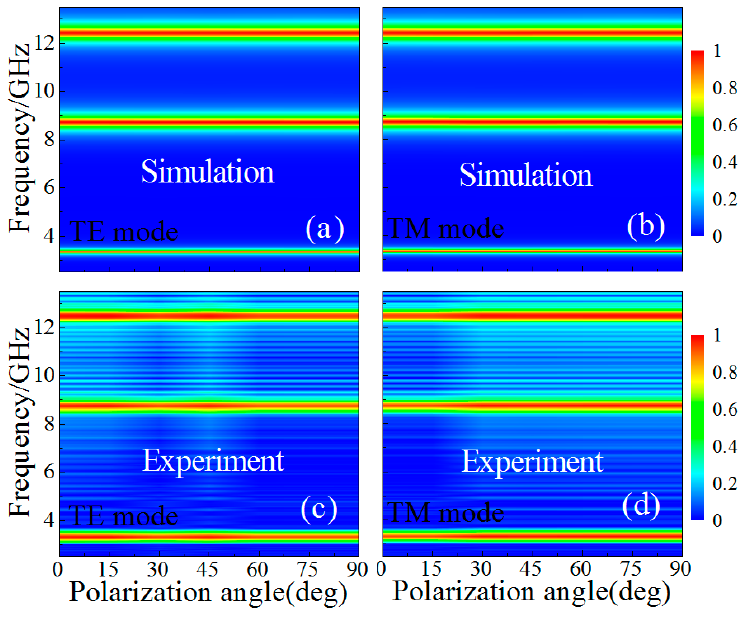
Figure 3. ( a , b ) Simulated and ( c , d ) experimental absorbance at different polarization angles with different modes: ( a , c ) transverse-electric (TE) mode, ( b , d ) transverse-magnetic (TM) mode.